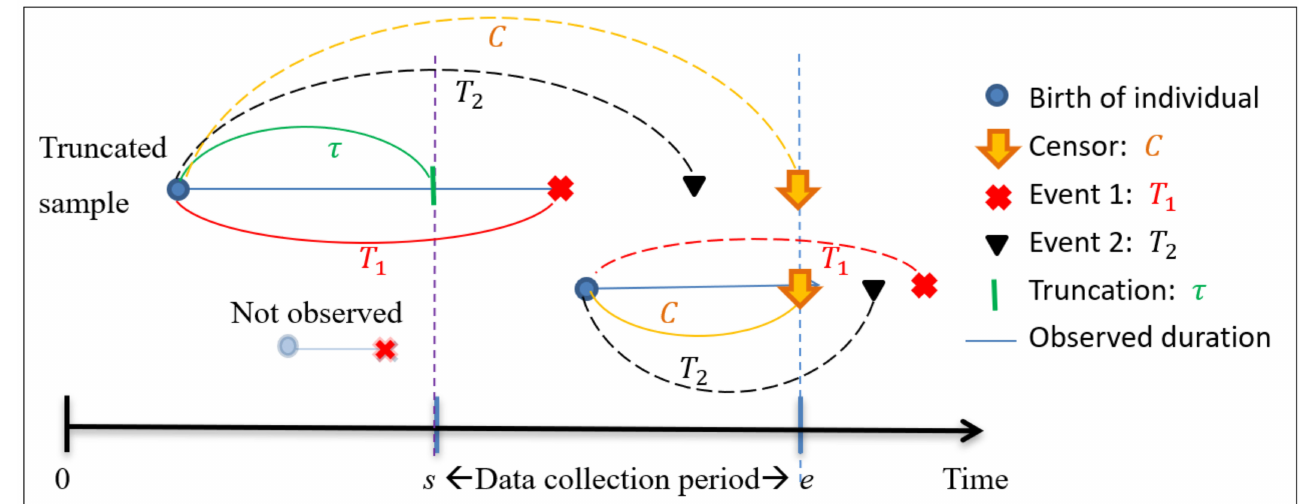
Figure 1. Left-truncated and competing risks data from a field study. Event 1 and Event 2 are subject to competing risks. Solid curves show observable times, and dashed curves show unobservable times. One can observe Event 1, Event 2, or Censoring, whichever occurs first, between the starting time ( s ) and the ending time ( e ). One cannot observe anything if Event 1 or Event 2 occurs before time s